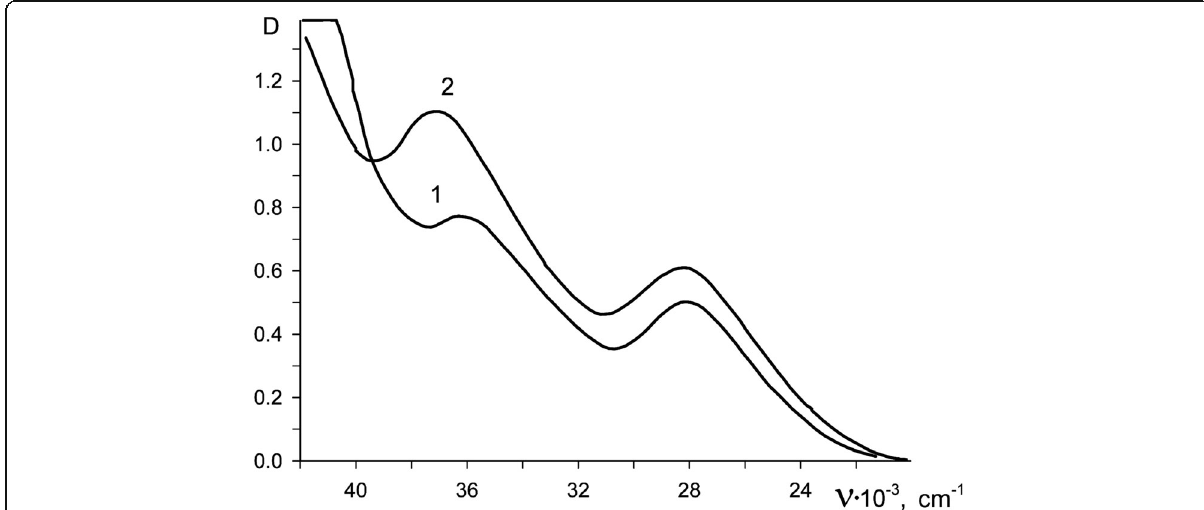
Fig. 2 Electron spectra of the complex Rh (III) ions in chloride-acetamide ( 1 ) and urea-chloride ( 2 ) melts at 120 °C